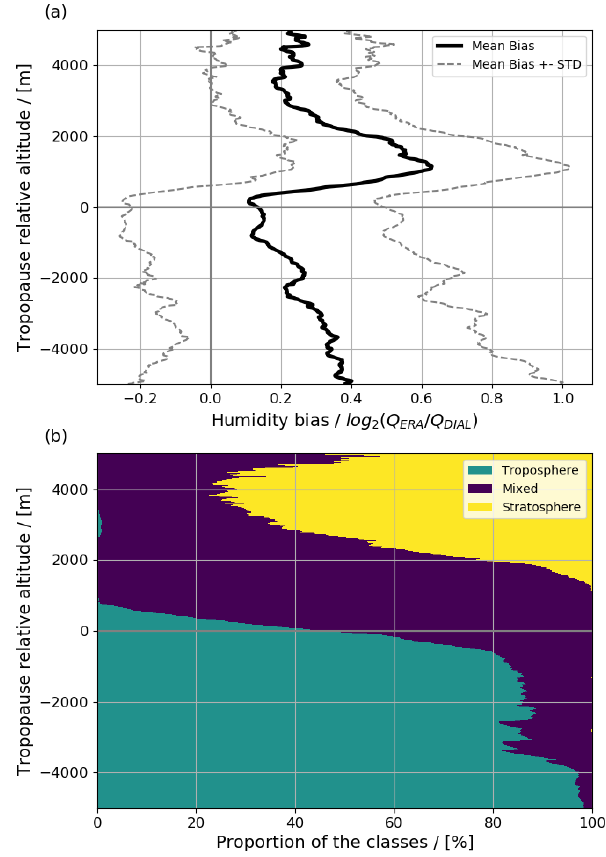
Figure 13. (a) Tropopause-relative vertical profile of the mean (thick black line) and standard deviation (dotted thin grey lines) of the humidity bias and (b) relative proportion of the individual air mass classes for four WISE